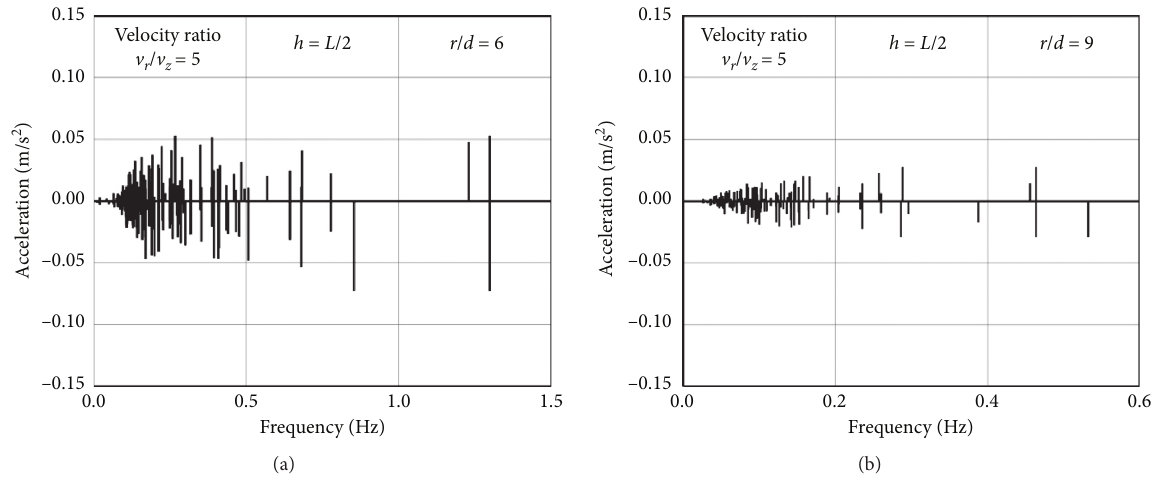
Figure 7: Acceleration amplitude and vibration frequency of the soil during drilling